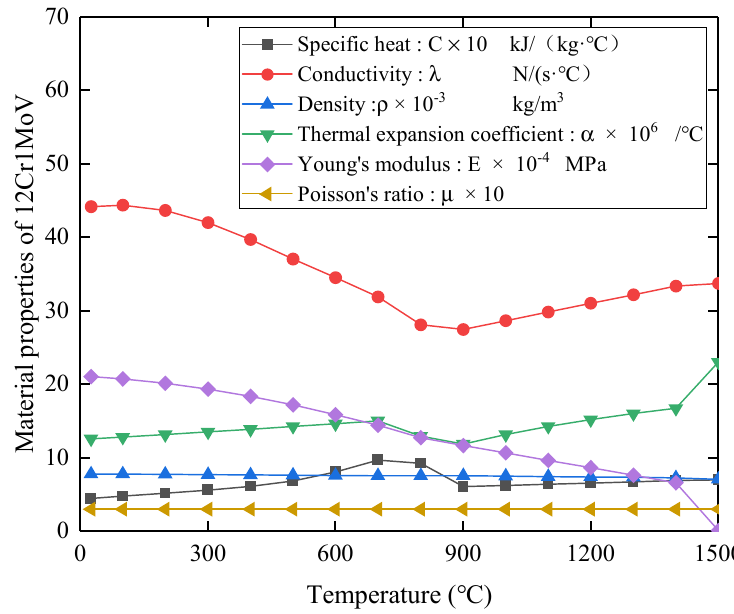
Figure 6. Thermal and mechanical properties of 12Cr1MoV.